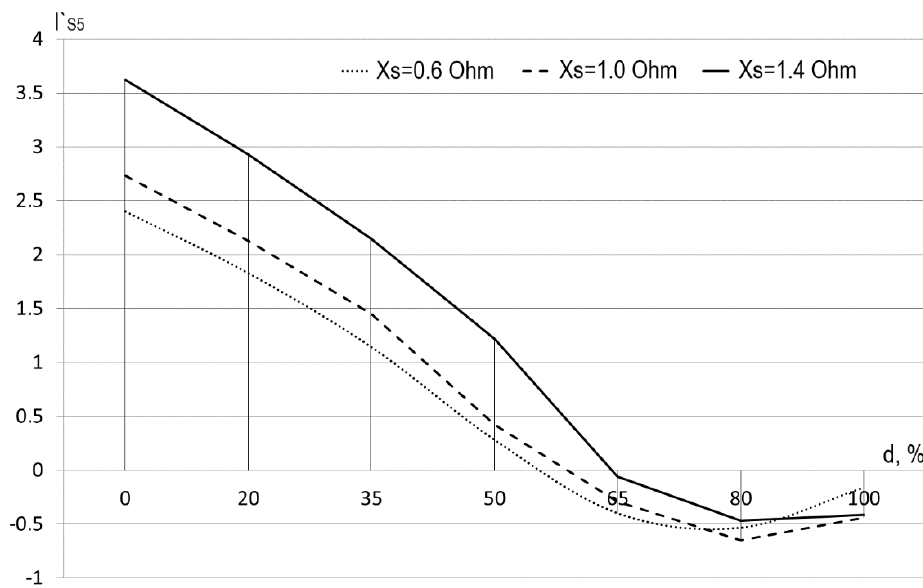
Figure 7. The dependences of the current derivative I’s 5 on d for various system impedance (X S ).